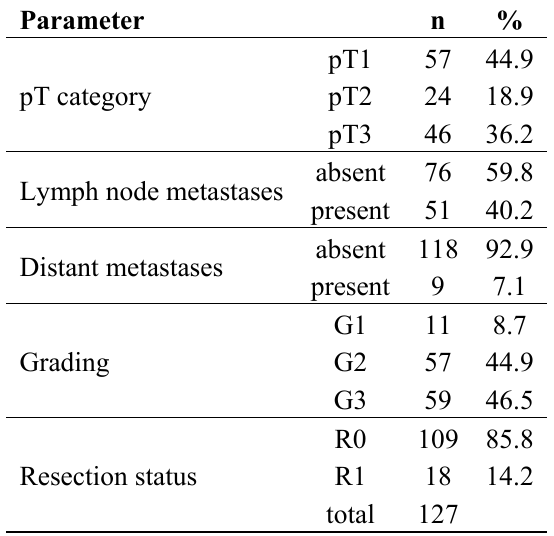
Table 1. Characterization of the case collective of primary resected esophageal